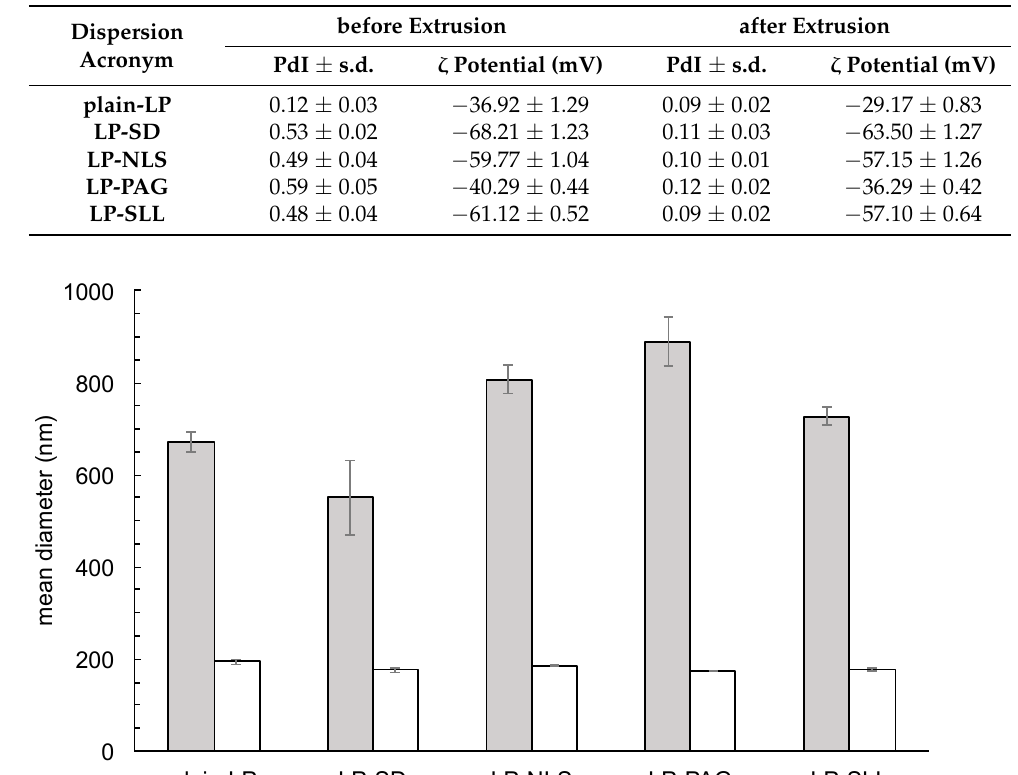
Figure 4. Cryo-TEM images of the produced unloaded anionic liposomes visualized after extrusion. Plain-LP ( a ), LP-SD ( b ), LP-NLS ( c ), LP-PAG ( d ) and LP-SLL ( e ), Bar corresponds to 250 nm.